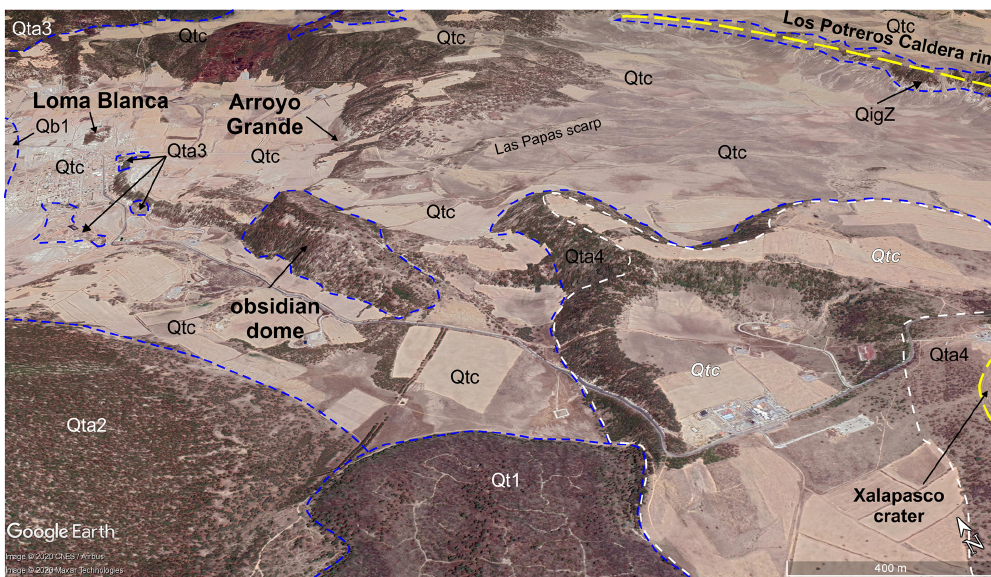
Figure 5. Perspective view from a satellite image of the Los Potreros caldera floor (Image Landsat from © Google Earth Pro, 2020, Inegi- Maxar Technologies; courtesy of Google). The dashed blue lines outline the lava domes and flows (Qta2, Qta3, Qb1, Qta4, Qt1) mapped by Carrasco-Núñez et al. (2017a), whereas the dashed white lines outline the mapping of the Cuicuiltic Member (Qtc) from Urbani et al.